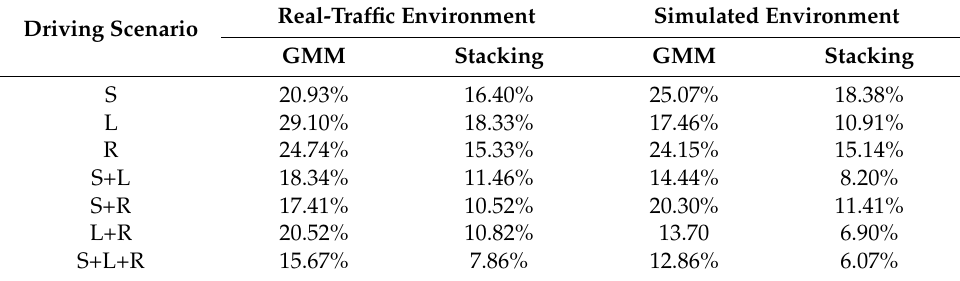
Table 4. EERs of the GMM and stacking approaches in real-traffic and simulated environments.